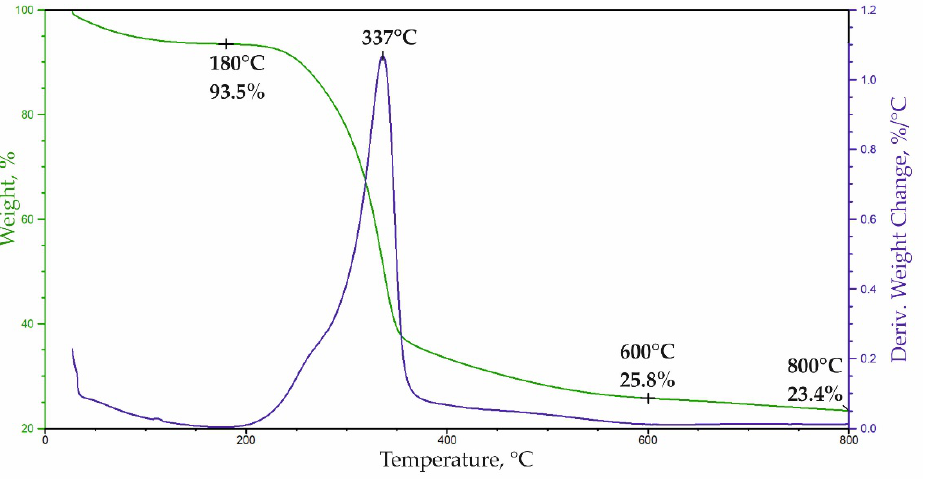
Figure 3. PXRD (Powder X-Ray Diffraction) diffractogram of ARBOCEL ® P 4000 X.